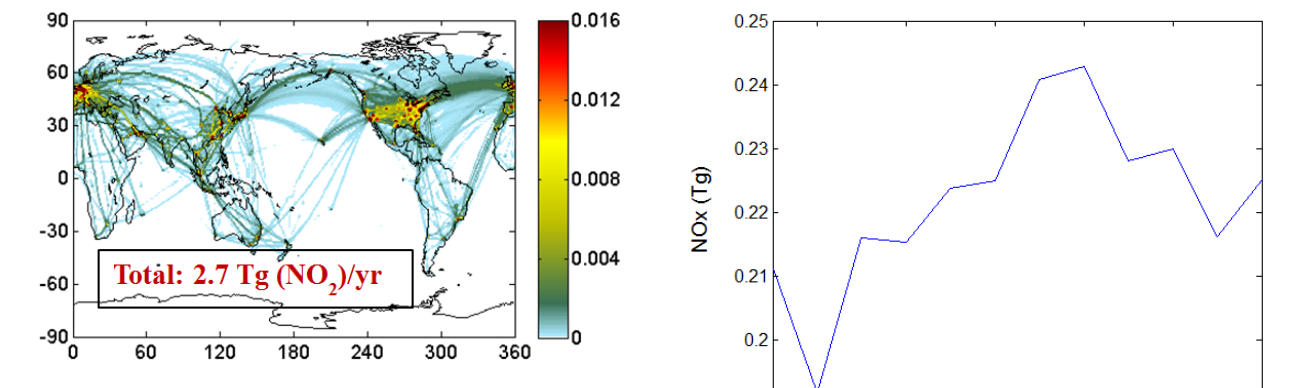
Figure 3. Spatial distribution of vertically integrated aviation NO x emissions for 2006.